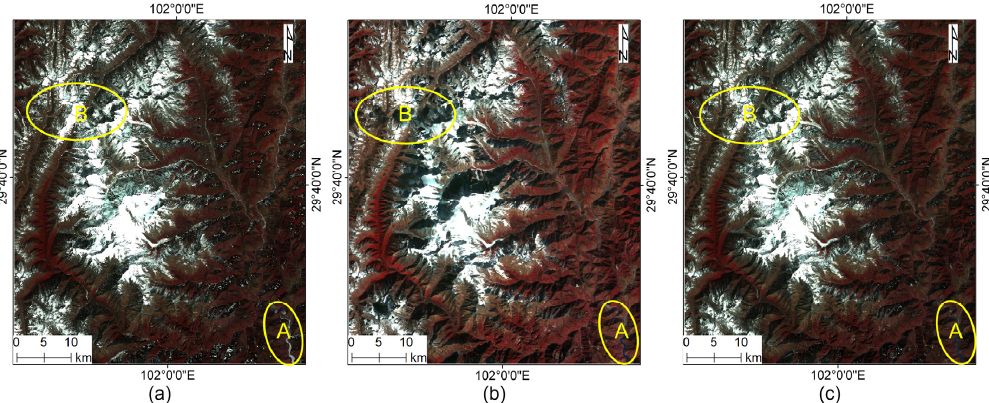
Figure 3. Cloud-free images generated by different composting methods: ( a ) Maximum NDVI; ( b ) Minimum blue; and ( c ) Combined compositing criterion. ( b ) Minimum blue; and ( c ) Combined compositing